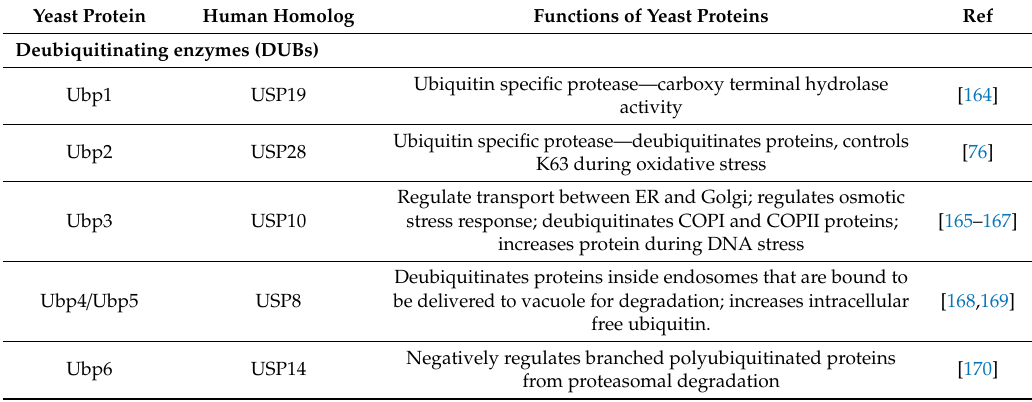
Table 4. Proteins of the yeast proteasome conserved in humans and their functions in